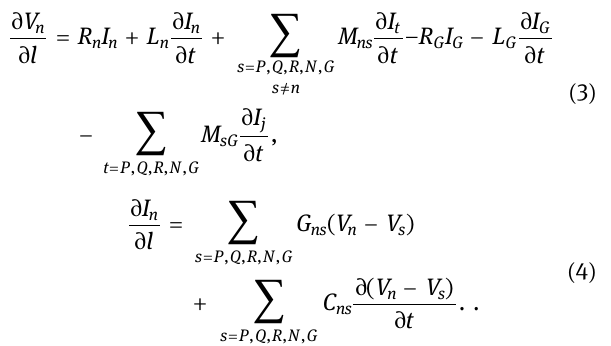
Figure 3: Mathematical modeling of four - core